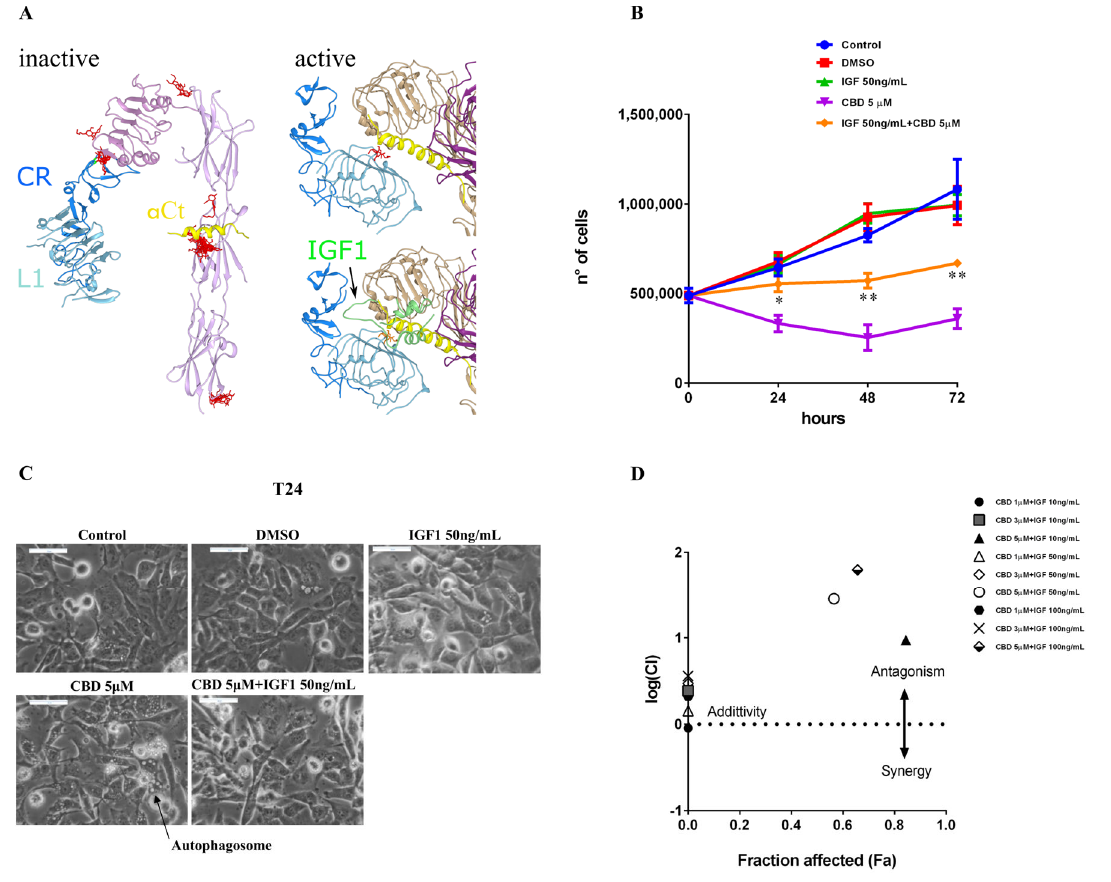
Figure 7. Docking experiments suggest that CBD can bind to overlapping sites with IGF-1. ( A ) Domains involved in the intermolecular interaction upon receptor activation are differently colored for identification: L1 domain is light blue, CR connector is blue, α Ct helix is yellow. CBD molecules are represented as red sticks. Left, the best poses of the top 20 clusters were reported for the Swissdock docking survey with CBD as a ligand and an inactive IGF-1R structure (PDB ID: 5u8r, minus the antibody chains) as a receptor. Top right, best pose from the flexible docking experiment on an active structure of IGF-1R (PDB ID: 6pyh, minus the natural ligand, IGF-1). The two different monomers are colored in purple (the α Ct belongs to this monomer) and tan (the visible L1 and CR belong to this monomer). Bottom right, the IGF-1 (green) position in the active receptor structure (6pyh) is shown, overlapping the CBD docking site. ( B ) MDA-MB-231 cells were plated on 24-well plates. After 24 h, cells were treated with CBD (5 µ M) alone or in combination with IGF-1 in a DMEM medium supplemented with 0.5% FBS. The number of viable cells was determined via Trypan blue staining at 0, 24, 48, and 72 h. Data are expressed as mean ± S.E.M. from three independent experiments. Differences among groups were analyzed using multiple t -tests. * p < 0.05, ** p < 0.01 indicates significance between IGF-1 50 ng/mL + CBD 5 µ M and CBD 5 µ M. ( C ) Cellular morphology of MDA-MB-231 cells treated as described above and after 24 h optical images were captured. Scale bar: 50 µ m. ( D ) MDA-MB-231 cells were seeded in 96-well plates. The day after, cells were treated with different concentrations of CBD (1, 3, 5 µ M) and IGF-1 (10 ng/mL, 50 ng/mL, 100 ng/mL), alone or in combination. Then 72 h later, cell viability was tested using MTT assay as described in Materials and Methods. Cell viability data were converted to Fraction affected (Fa) values and analyzed by CompuSyn software to obtain a combination index plot. log(CI) < 0, synergism; log(CI) = 0, addictive effect; log(CI) > 0, antagonism. Black hexagon (CBD 1 µ M + IGF 100 ng/mL) is partially covered by gray box (CBD 3 µ M + IGF 10